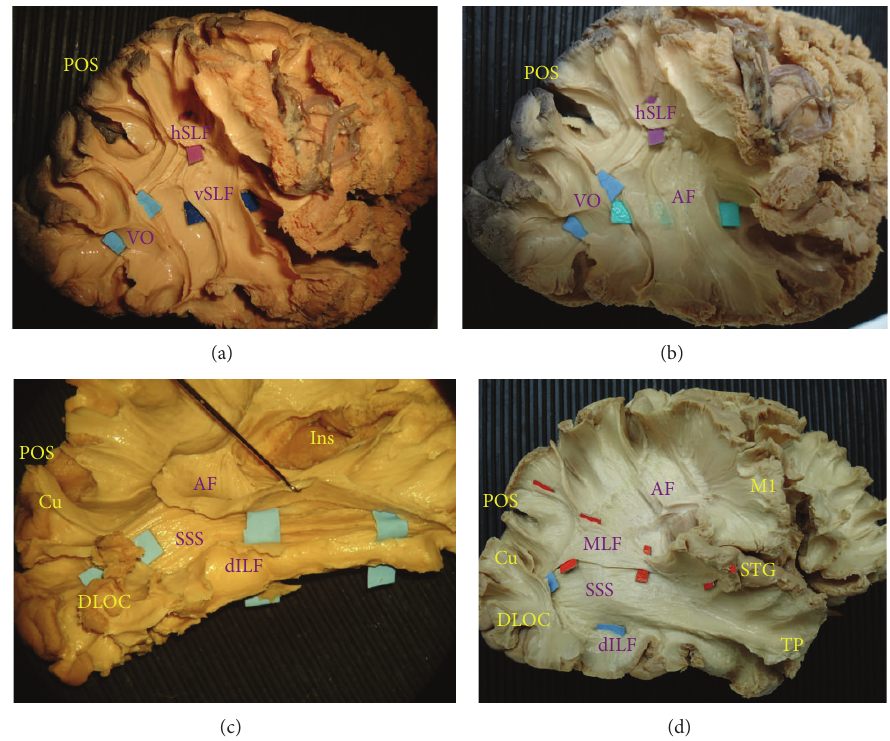
Figure 1: (a) Lateral view of a right hemisphere after the dissection of the superficial white matter layers of temporo-parieto-occipital region. The first bundle identified is the vertical component of the superior longitudinal fasciculus (vSLF/dark blue), which connects the supramarginal gyrus and angular gyrus to the temporo-occipital junction. Posterior to the vSLF, the vertical occipital fasciculus (VO/light blue) connects the superior occipital gyrus to the fusiform gyrus. At the level of the supramarginal gyrus the vSLF partially overlaps with the horizontal component of SLF (hSLF/purple), which runs from the parietal region to the frontal region. (b) After vSLF has been removed the arcuate fasciculus (AF/cyan) is exposed running from the frontal region through the perisylvian region with white matter terminations underneath the temporo-occipital junction and it ends at the level of the middle and inferior temporal gyrus. (c) The temporal terminations of the AF are overlapping with the temporal portion of the dorsal inferior longitudinal fasciculus (dILF/light blue). The AF has been retracted completely exposing the course of dILF. The cuneal (Cu) branch and the dorsolateral occipital cortex portion (DLOC) run in one bundle (dILF) at the level of the temporo-occipital junction lateral to the SSS and straight to the temporal pole area. (d) Medial to the AF, the middle longitudinal fasciculus (MLF/orange) is exposed at the connection between the posterior insular cortex (Ins) and the superior temporal gyrus (STG). This bundle runs from the superior temporal gyrus within the sagittal stratum of Sachs (SSS) to the parieto-occipital sulcus region (POS). At the level of the cuneal region (Cu) the dILF terminations are partially overlapping the MLF terminations. M1 : primary motor cortex (precentral gyrus); Ins: insula; TP: temporal pole